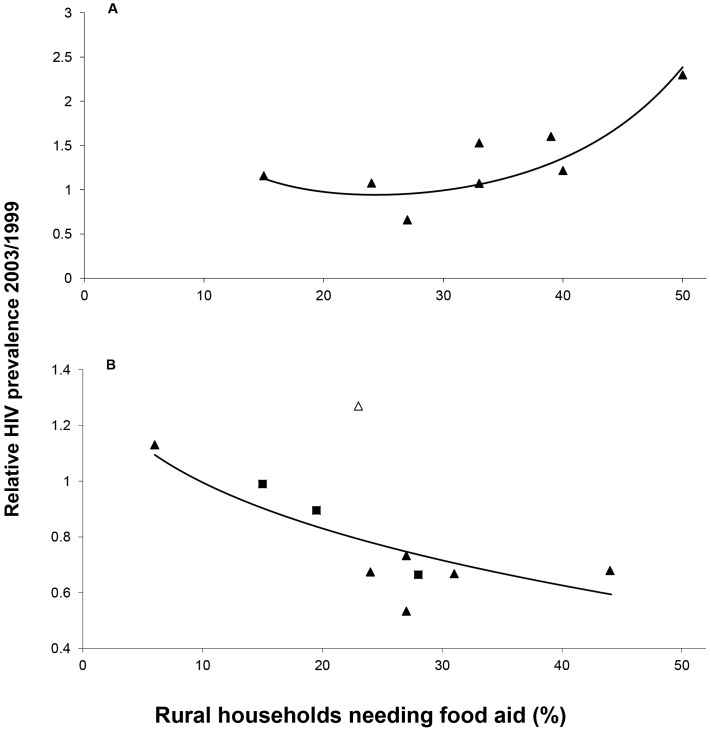
Change in HIV prevalence at antenatal sites through the famine in relation to rural hunger.The independent variable is the proportion of rural households estimated from a humanitarian survey to be in need of food assistance in December 2002—March 2003 in the district surrounding antenatal sites. The observed values of the dependent variable are the ratio of the HIV prevalence in women attending antenatal clinics in 2003, after the worst of the famine, to the prevalence in 1999/2000, prior to the rapid rise in food prices. The fitted values are from multilevel log binomial regression (model 1, Table 2). (A) Rural sites. The quadratic equation has a vertex at approximately 25%, implying little change in HIV around this level of hunger. (B) Non-rural sites (squares: cities, triangles: towns, open triangle: Nsanje, which is included in the analysis).